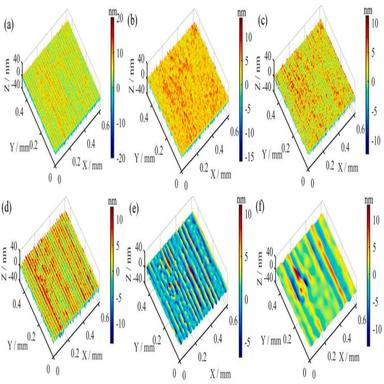
(a–f) are the surface texture within the 1st to the 6th scales at the machining condition III of, respectively.